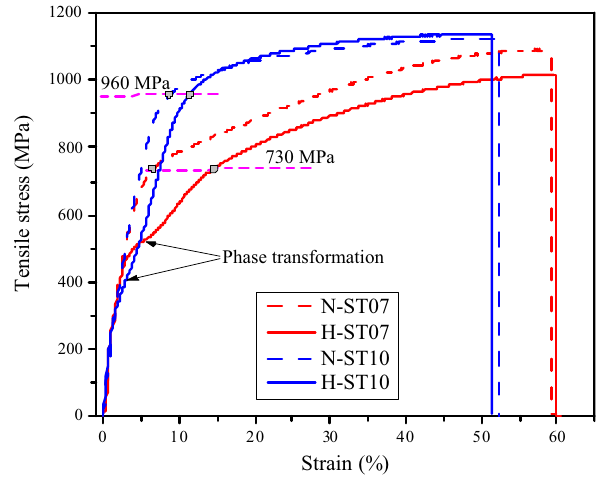
Figure 1: Tensile behavior of cold - drawn SMA fi bers with and without heating.